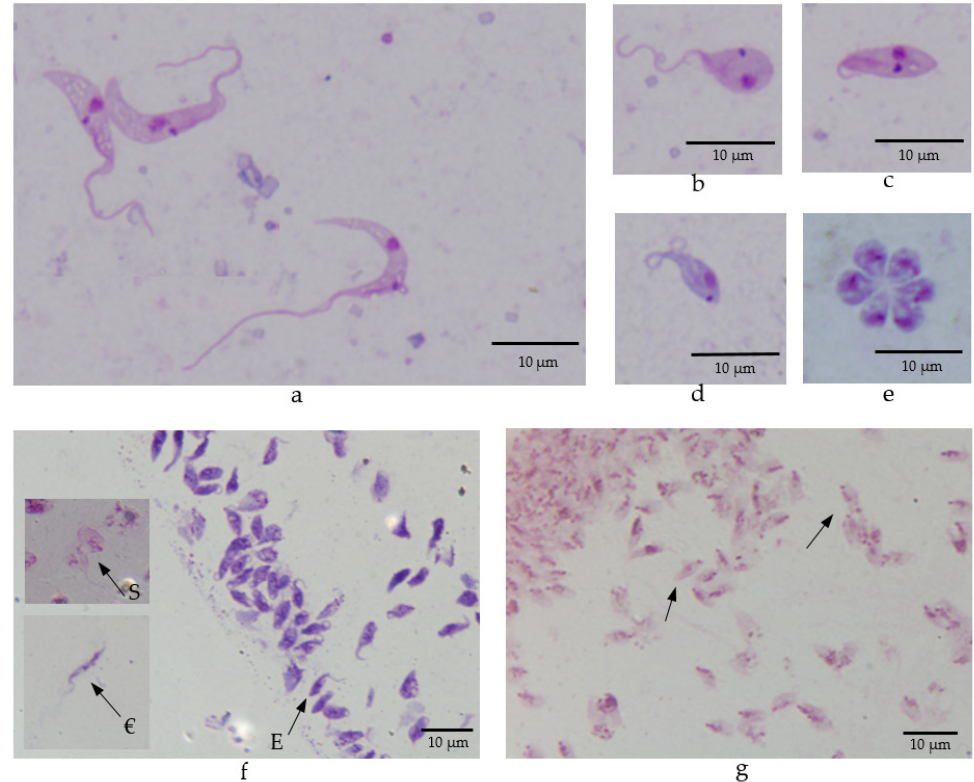
Figure 5. T. theileri morphotypes observed after infection of Ph. perniciosus ( a – d ) or Ae. aegypti ( e ) with CUL46 strain (ex Cs. annulata ): a —elongated epimastigotes, b —spheromastigote, c —droplet-shaped epimastigote, d —metacyclic stage, e —rosette; ( f , g ): T. theileri morphotypes in prediuresis experiments with Ae. aegypti and CUL46 strain: f —elongated epimastigote (inset) ( € ), droplet-shaped epimastigotes (E), and spheromastigote (inset) (S), g —metacyclic stages (trypomastigotes; arrows).